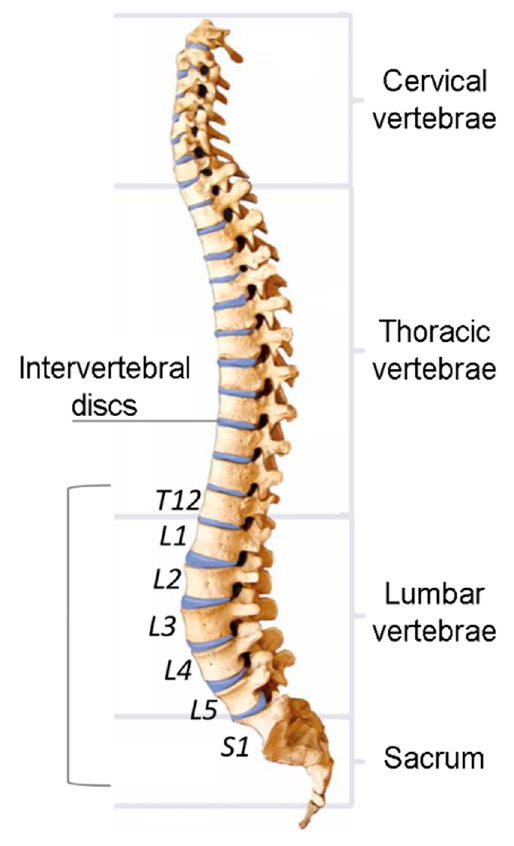
Figure 3. Disc level of the lumbar spine.